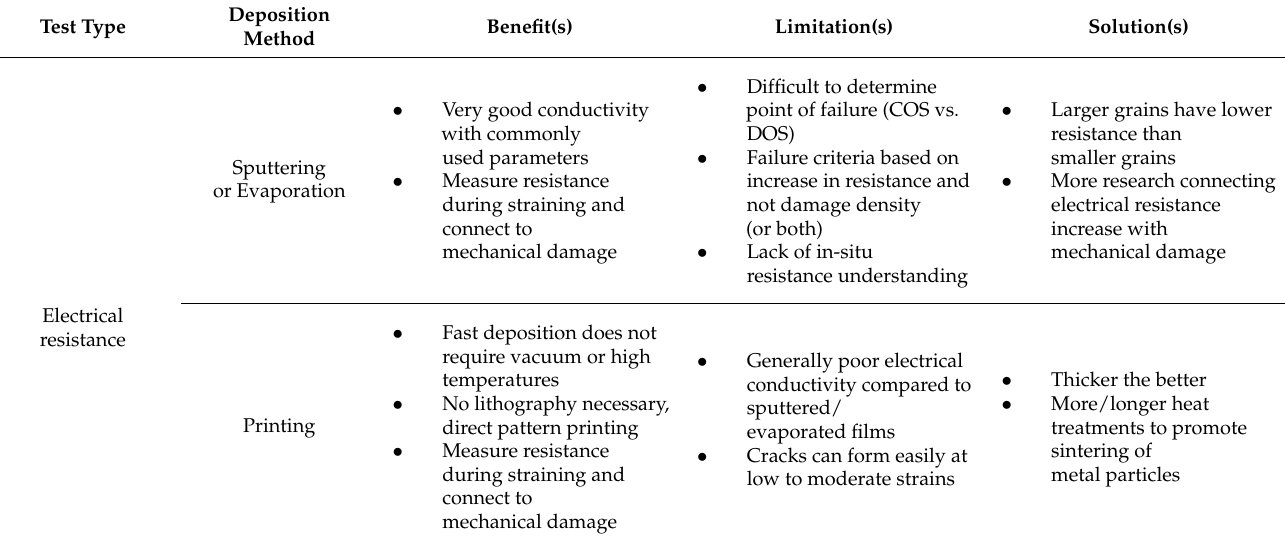
Table 1. Summary of benefits, limitations, and possible solutions for electrical resistance-based and cyclic